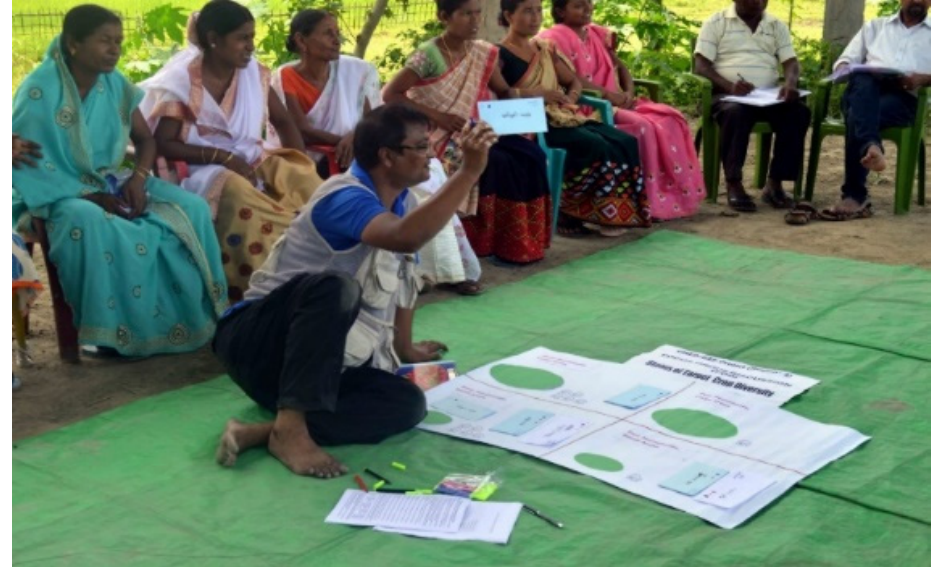
Figure 1. Focus group discussion using the four-cell analysis method at the Alengmora study site, India (Photo Credit: Rajib Sarma).